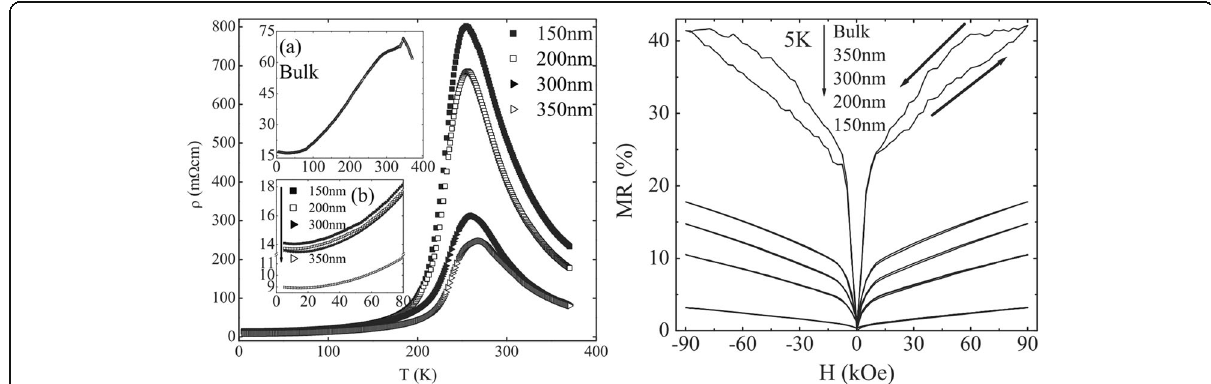
Fig. 38 a ρ -T plots for the La 0.7 Pb 0.3 MnO 3 (LPMO)/LaAlO 3 (LAO) thin films grown by chemical solution deposition (CSD) method with various thicknesses. Inset ( a ): resistivity vs. temperature plot for bulk LPMO sample. Inset ( b ): enlarged view of low temperature (below 80 K) dependent resistivity behavior for the LPMO/LAO thin films having various thicknesses. b MR vs. H isotherms recorded at 5 K for the CSD grown LPMO/LAO thin films with different thicknesses and bulk LPMO sample. Reproduced with permission of [115]